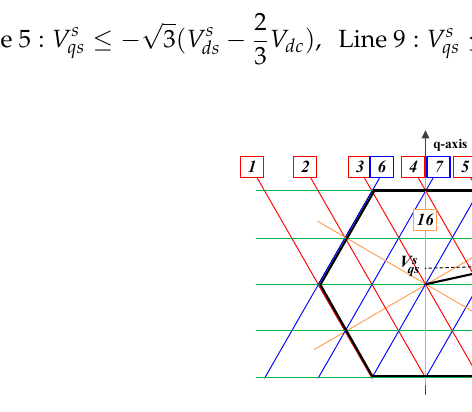
Figure 15. Lines (1–18) for the classification of 36 switching sectors.